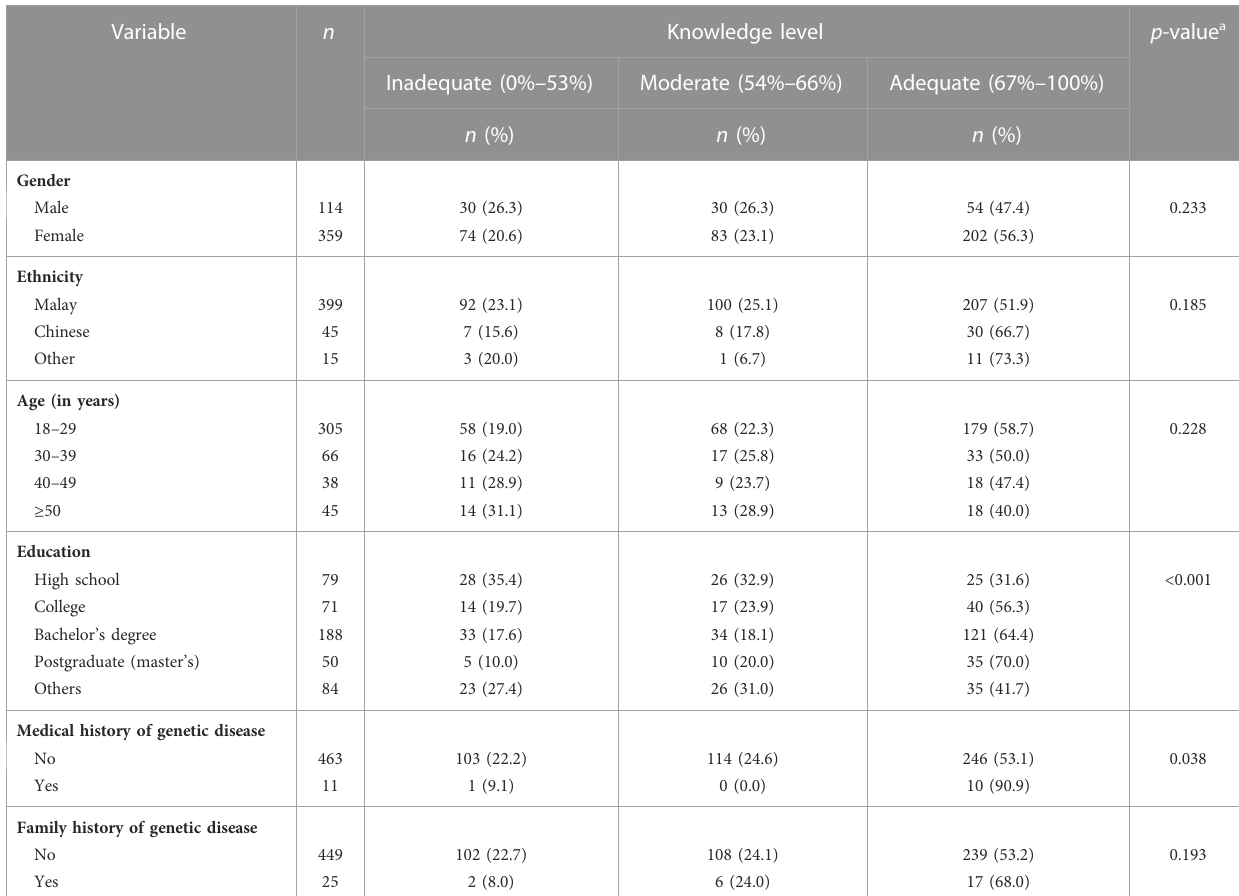
TABLE 4 Association between respective variables and participant ’ s knowledge level of